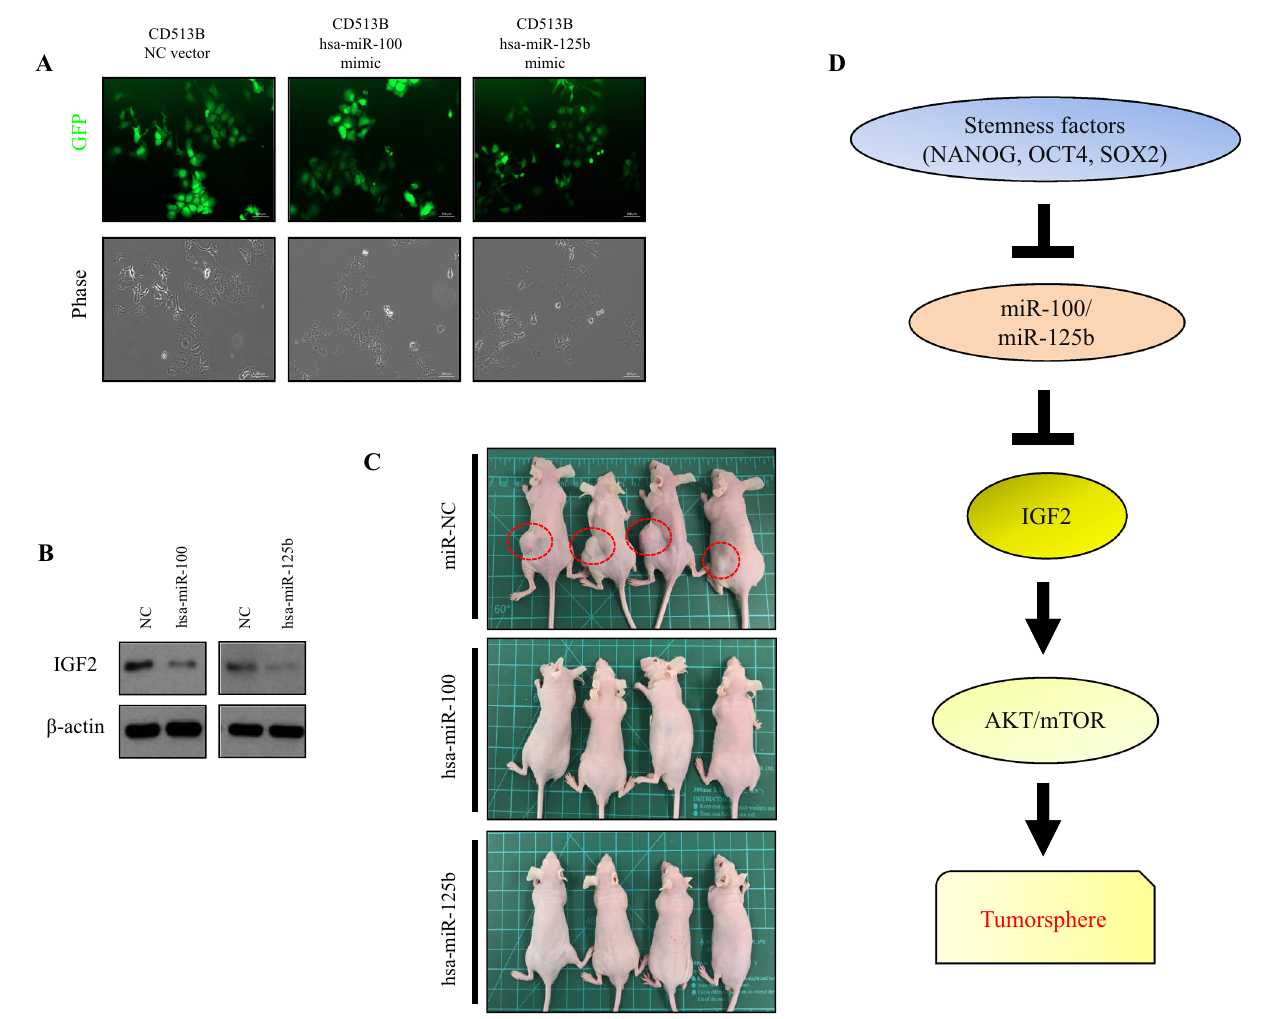
Figure 5. Spheres lose their stemness character with inhibition of IGF2. ( A ) Hep3B sphere forming ability was detected after treatment with different concentrations of chromeceptin. Dimethylsulfoxide (DMSO) was used as the control chemical. Blots were cropped to show specific bands. ( B ) Spheres were enumerated by microscopy examination and the data were graphed. ( C ) Graph showing tumorsphere (TS) inhibition ability after chromeceptin treatment. ( D ) Representative immunoblot of the time-dependent expression of p -AKT, pan-AKT, p -mTOR (ser2481 and ser2448), mTOR, and p 70s6k (ser371) in 2D and TS upon treatment with chromeceptin. β-actin was used as a loading control. Blots were cropped to show specific bands. ( E ) Chromeceptin anti-cancer effect was detected with 3D cell titer GLO in hepatocellular primary cells derived patients for 72 h. The inhibition effects were normalized with DMSO treatment. Immunoblots used β-actin as a loading control. The average (column) ± SD (bar) is indicated ( * p < 0.05, ** p < 0.01, *** p < 0.001).